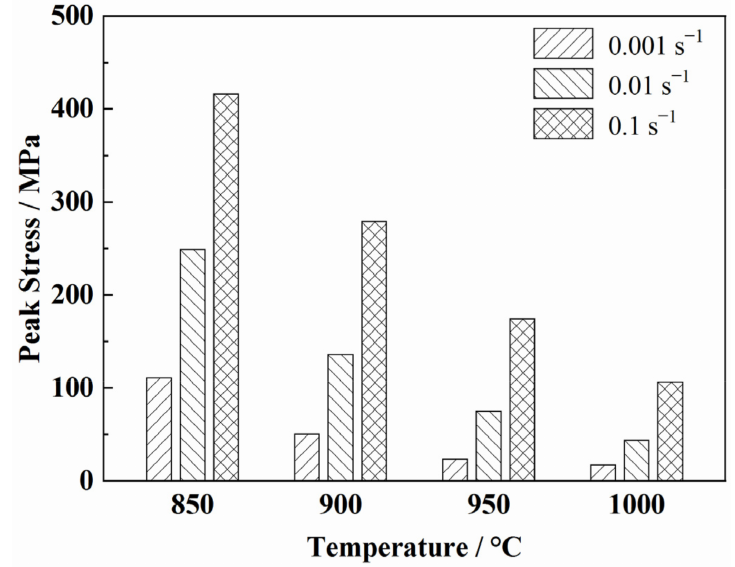
Figure 4. Peak stress at different temperatures and strain